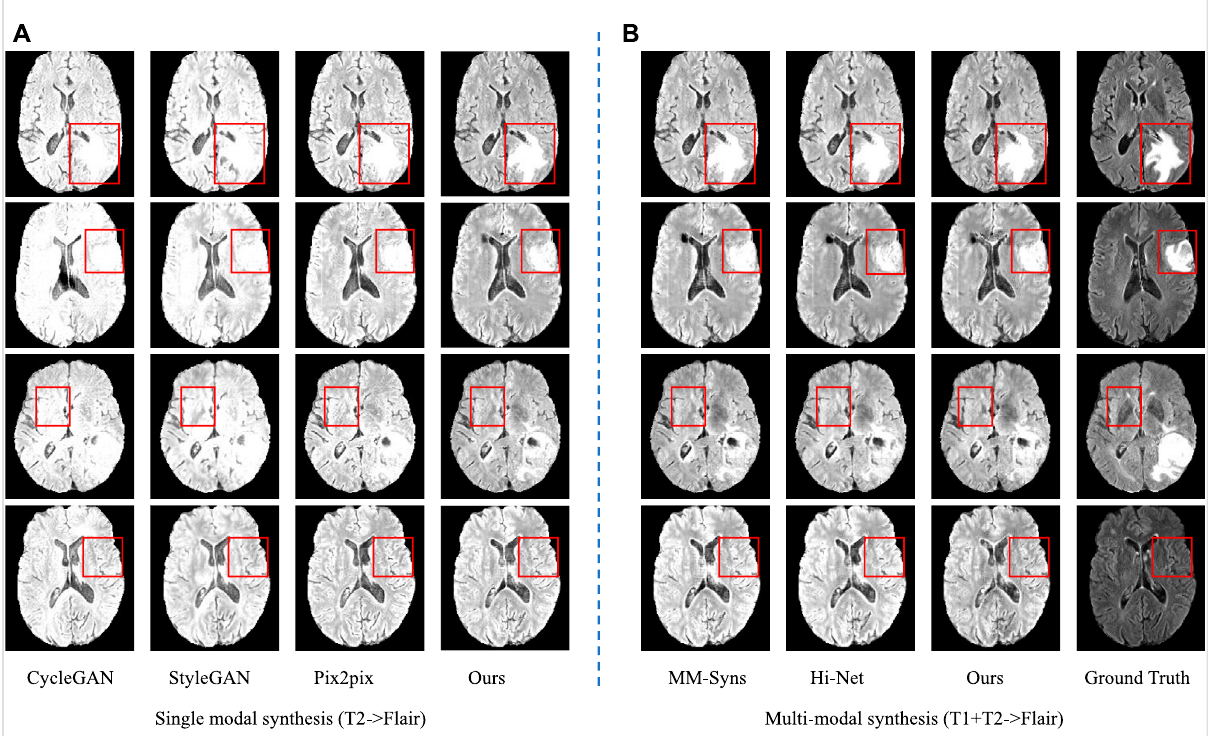
FIGURE 7 Synthesis results of single modal and multimodal. (A) is the sing modal results using T2 to synthesize Flair; (B) is the multimodal results using T1 and T2 to synthesize Flair.